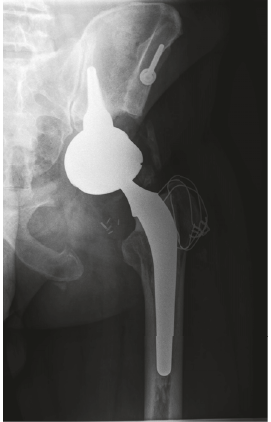
Figure 3: Radiographs: 12 months after